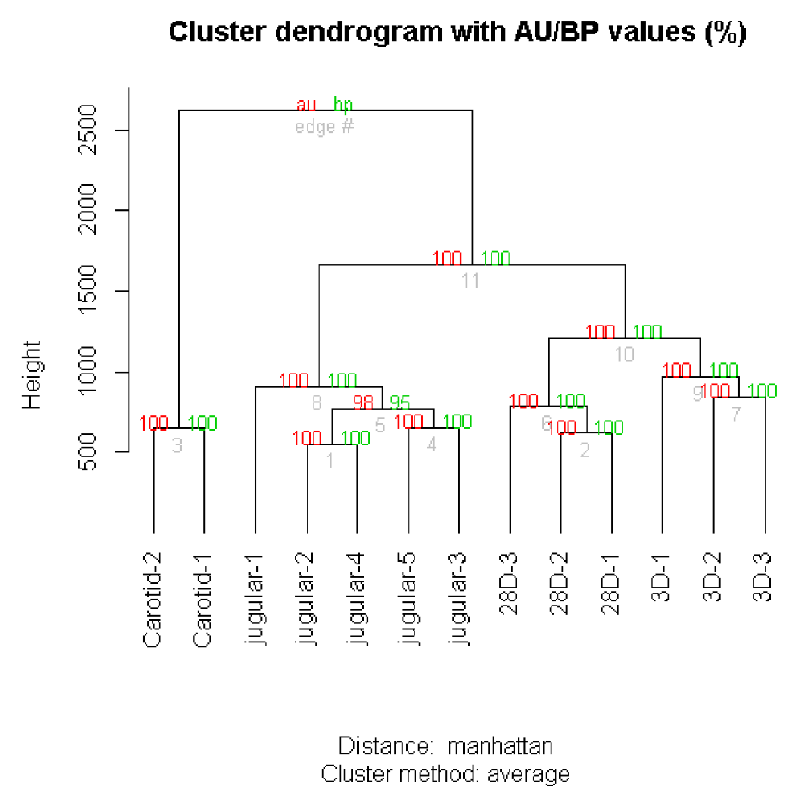
Figure 2. Hierarchical clustering of the differentially expressed genes dataset (1845 genes) determined by multiple comparisons. Values at the branches are AU p -values (red), BP values (green), and cluster labels (bottom).